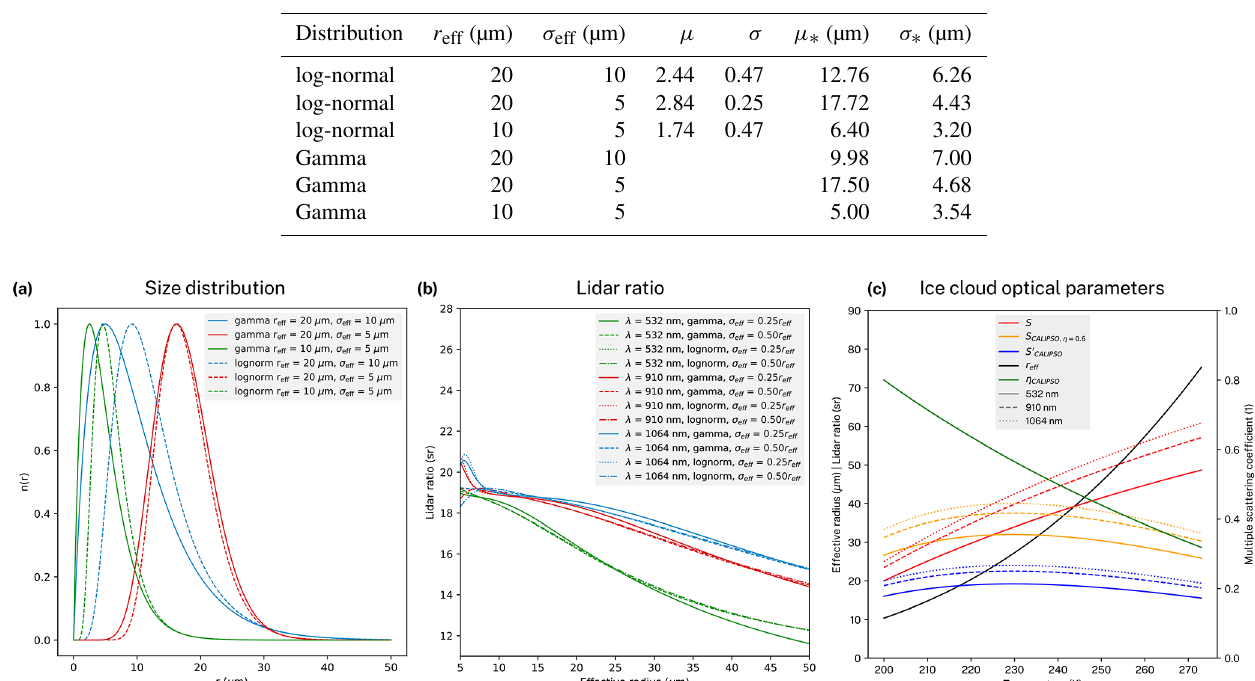
Figure 2. (a) Theoretical distributions of cloud droplet radius based on the log-normal and gamma distributions parameterised by multiple choices of the effective radius r eff and effective standard deviation σ eff . (b) Lidar ratio (LR) as a function of effective radius calculated for different theoretical cloud droplet size distributions, laser wavelengths and effective standard deviation ratios. (c) Parameterisation of ice cloud optical properties as a function of temperature based on Garnier et al. (2015) and Heymsfield (2005). The plot shows LR ( S ), LR of CALIPSO calculated using the constant standard processing multiple-scattering coefficient η = 0 . 6 ( S CALIPSO ,η = 0 . 6 ), the effective LR of CALIPSO ( S (cid:48) ), the effective radius ( r eff ) and the multiple-scattering coefficient of CALIPSO ( η CALIPSO ) determined by Garnier CALIPSO et al. (2015). LRs are calculated for three wavelengths of 532nm (solid line), 910nm (dashed line) and 1064nm (dotted line) by scaling with the colour